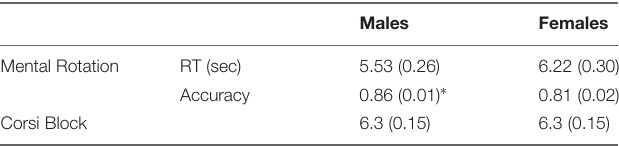
TABLE 2 | Mean performance ( + / − SEM) on tasks of general spatial abilities in males and